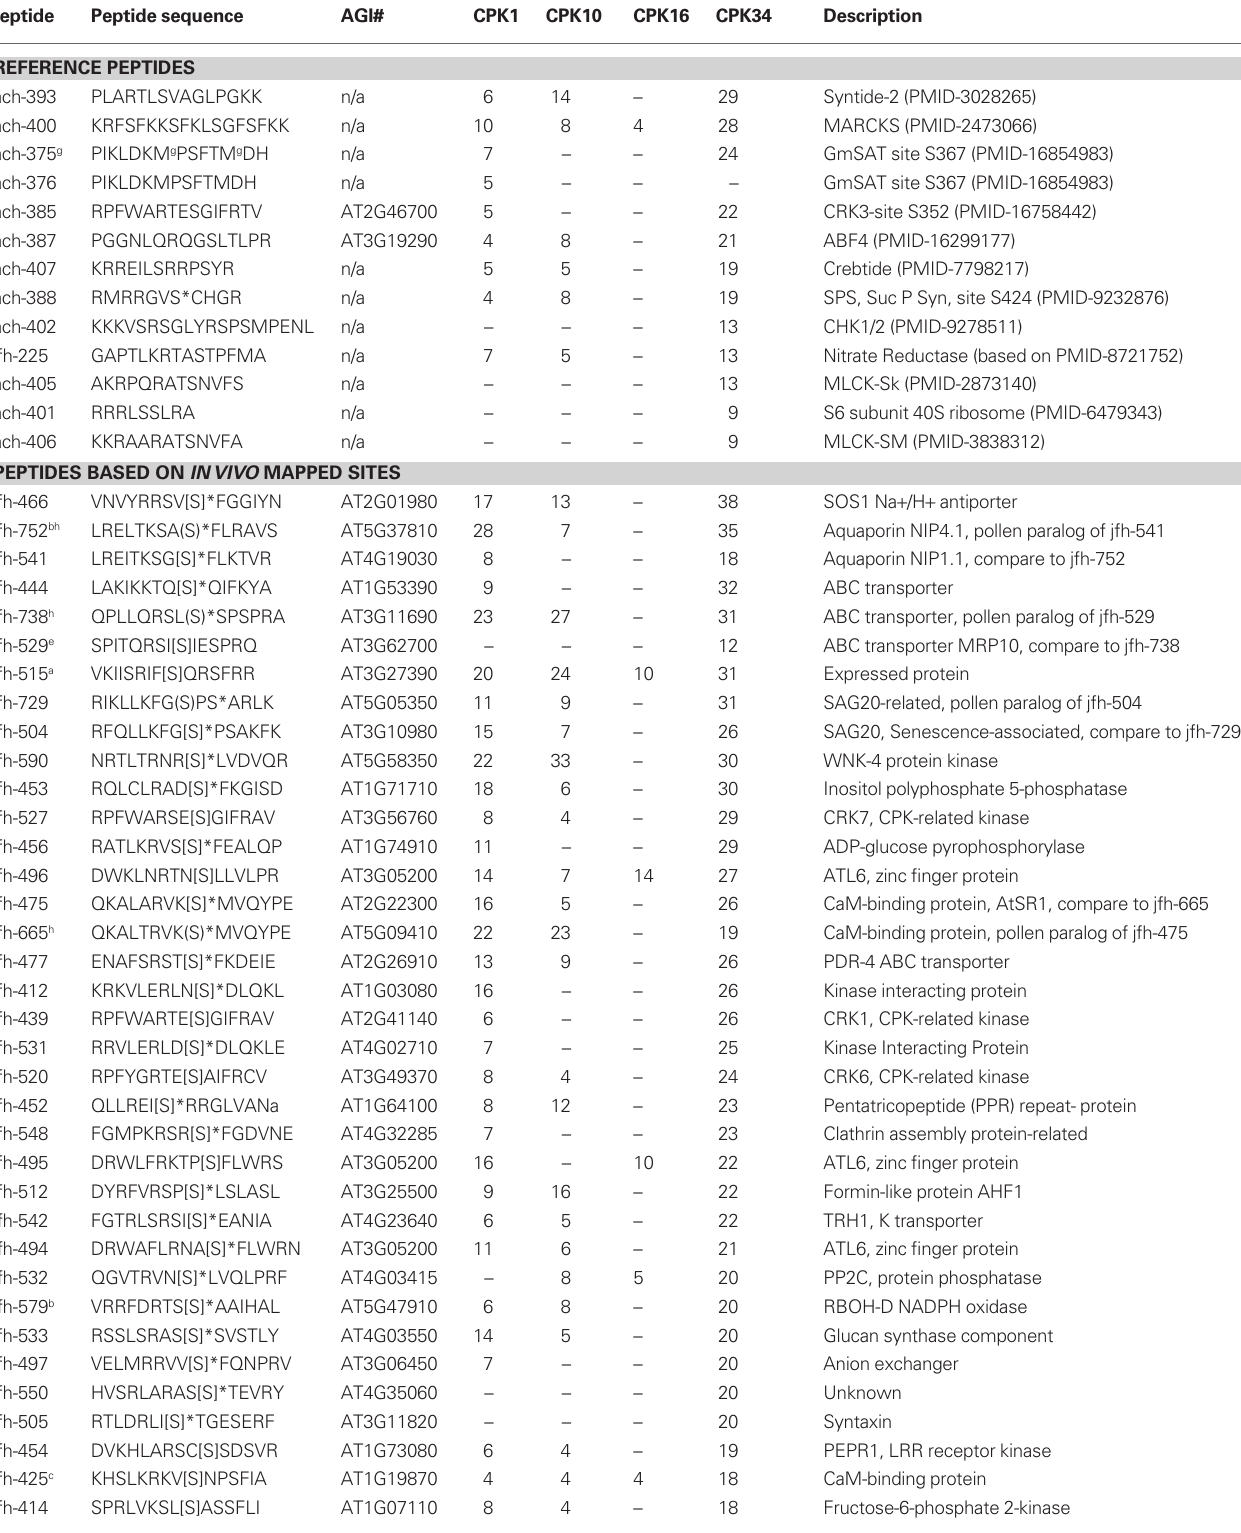
Table 1 | One hundred two peptides phosphorylated by at least one CPK in this study. Peptide Peptide